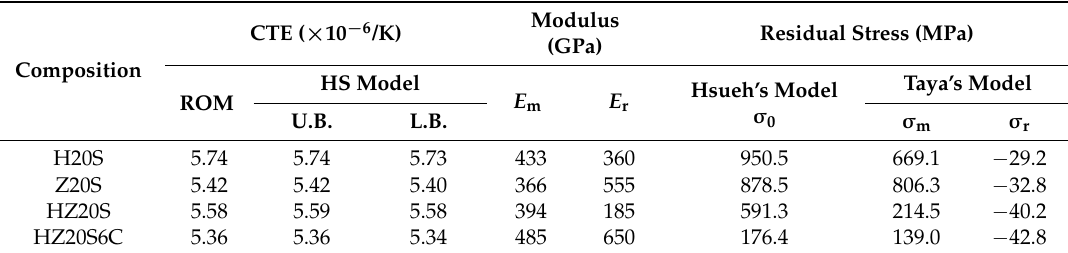
Table 3. Theoretical calculation of the coefficient of thermal expansion (CTE), modulus and residual stresses. Here, ROM = rule of mixture, HS = Hashin-Shtrikman, U.B. = upper bound, L.B. = lower bound, E m = elastic modulus of the matrix, E r = elastic modulus of reinforcement, σ m = residual stress of the matrix, and σ r = residual stress of the